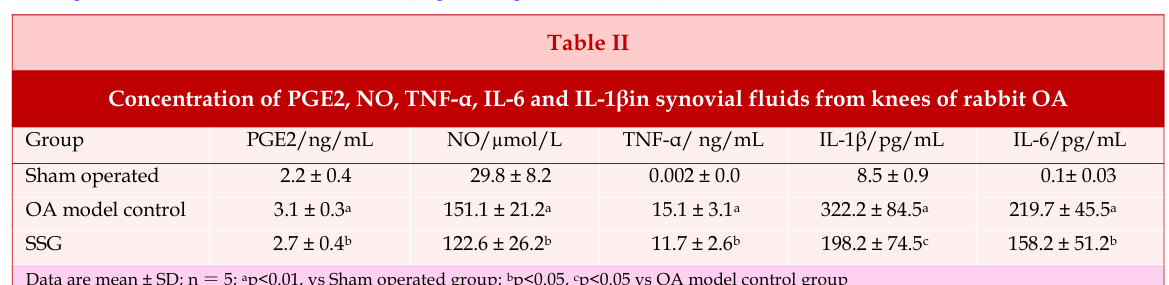
Figure 2. Histologic examination of cartilage change in rabbits of sham operated (A), OA model control (B) and SSG (C) groups. Cartilages were stained with toluidine blue. (original magnification ×